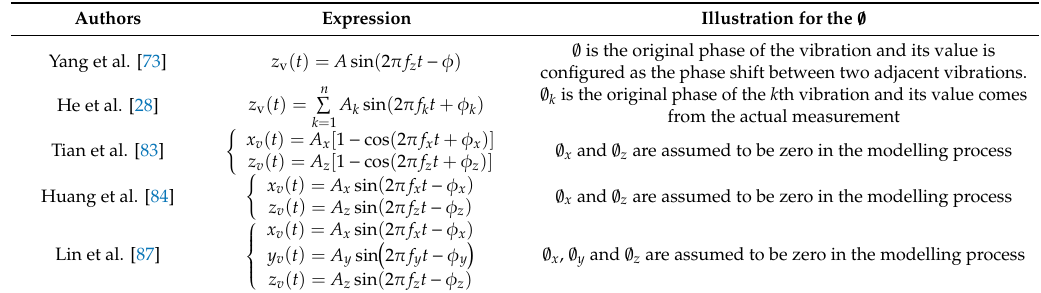
Table 2. Theoretical results for the vibrations employed in the surface topography modelling